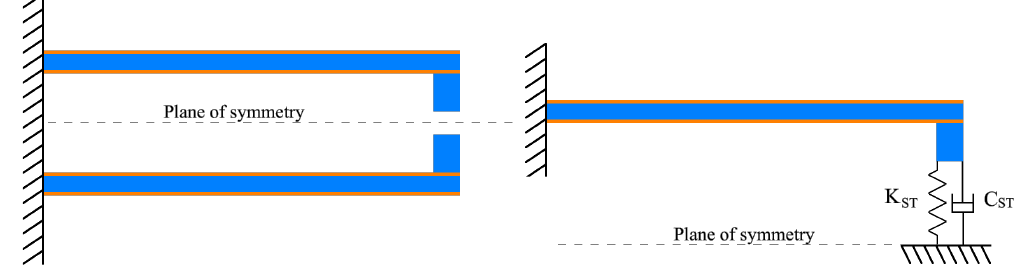
Figure 7. Scheme used for the simulations. Table 2. Comparison between the actual Young’s modules and those obtained by the model; E mm is the Young’s modulus obtained by the mathematical model.